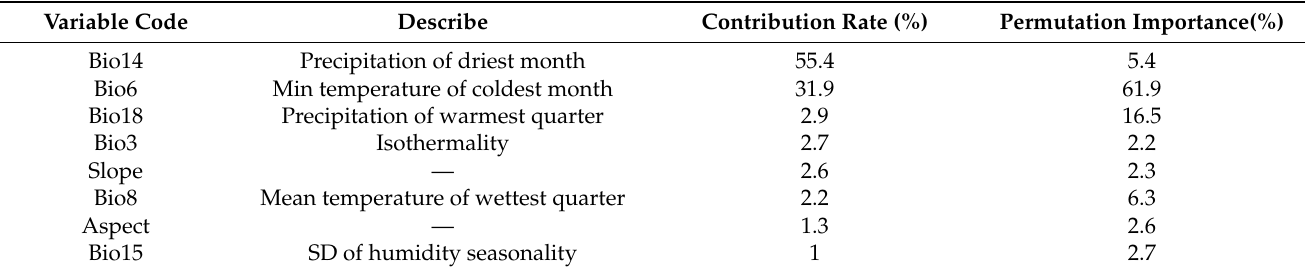
Table 1. Contribution rate of each environmental factor in MaxEnt mode.